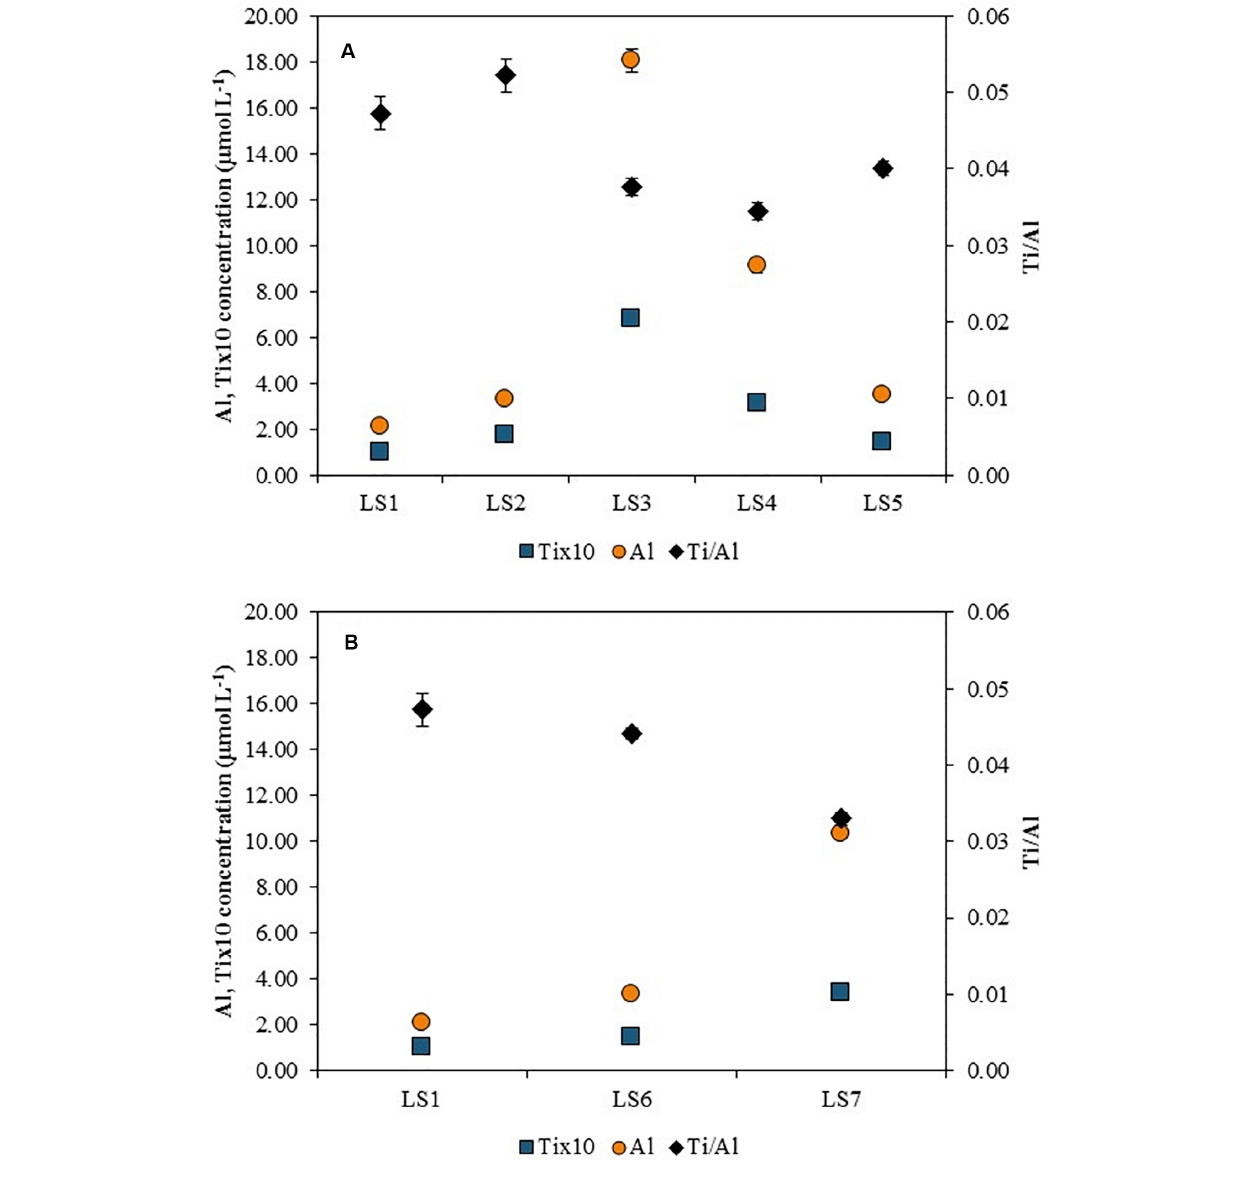
FIGURE 6 | Total Al and Ti concentrations (left-hand side axis) and Ti/Al elemental ratios (right-hand side axis) along (A) Orleans city (LS1 to LS5) and in (B) the outdoor activities center (LS6 and LS7 compared with LS1) after an acid